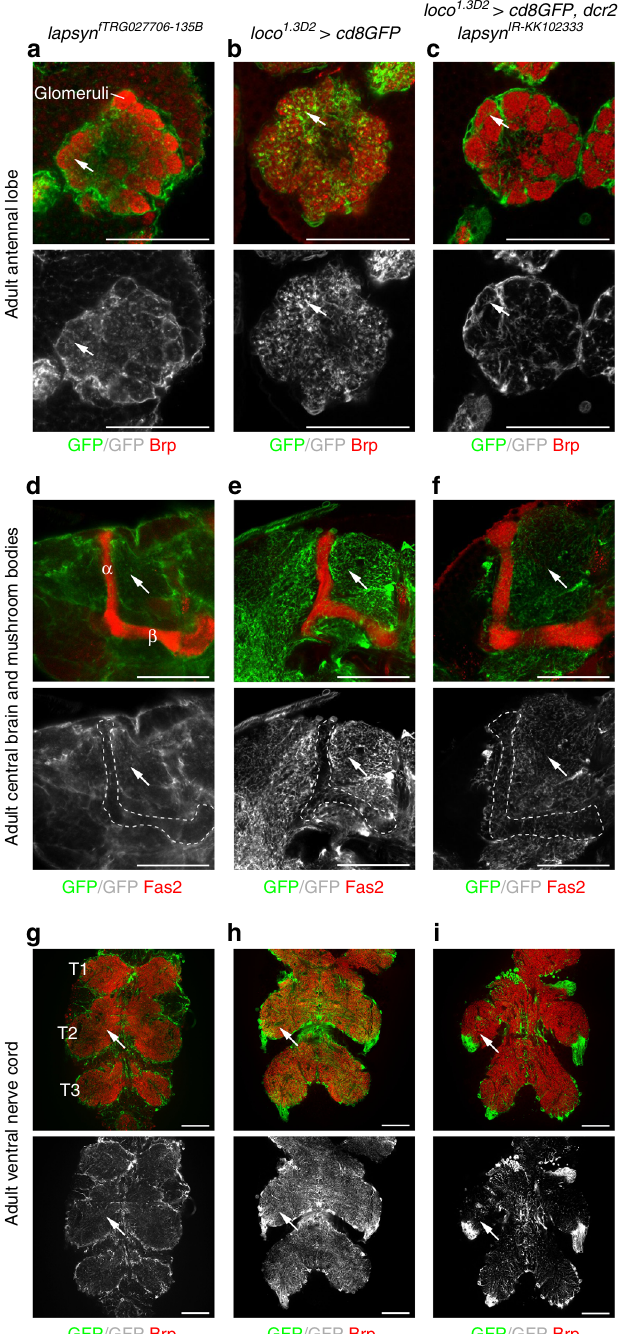
Fig. 9 lapsyn is widely required for branch morphogenesis of astrocyte-like glia in the CNS. Brp was used to visualize synaptic neuropils ( red , a – c , g – i ). Fas2 labeled the mushroom body lobes ( d – f , red ). a , d , g The fosmid lapsyn fTRG027706 reported lapsyn expression ( green , arrows ) in adult astrocyte-like glia extending into glomeruli within the antennal lobe ( a ), the neuropils of the central brain ( c ), and the VNC ( g ) in addition to other glia. b , e , h loco 1.3D2 -Gal4 UAS-cd8GFP ( green ) labeled branches of astrocyte-like glia in all examined CNS areas. In mushroom body α and β lobes ( d , e , f , outlined ), lapsyn expression was weak, in line with the low density of astrocyte-like glial branches labeled with loco 1.3D2 -Gal4 UAS-cd8GFP , limiting assessment of defects following lapsyn knockdown. Compared to controls b , e , h , the knockdown of lapsyn in astrocyte-like glia resulted in reduced branch morphogenesis ( arrows ) in the adult antennal lobe, the central brain and VNC ( c , f , i ). All panels show single optical sections. For genotypes and sample numbers, see Supplementary Table 1. Scale bars